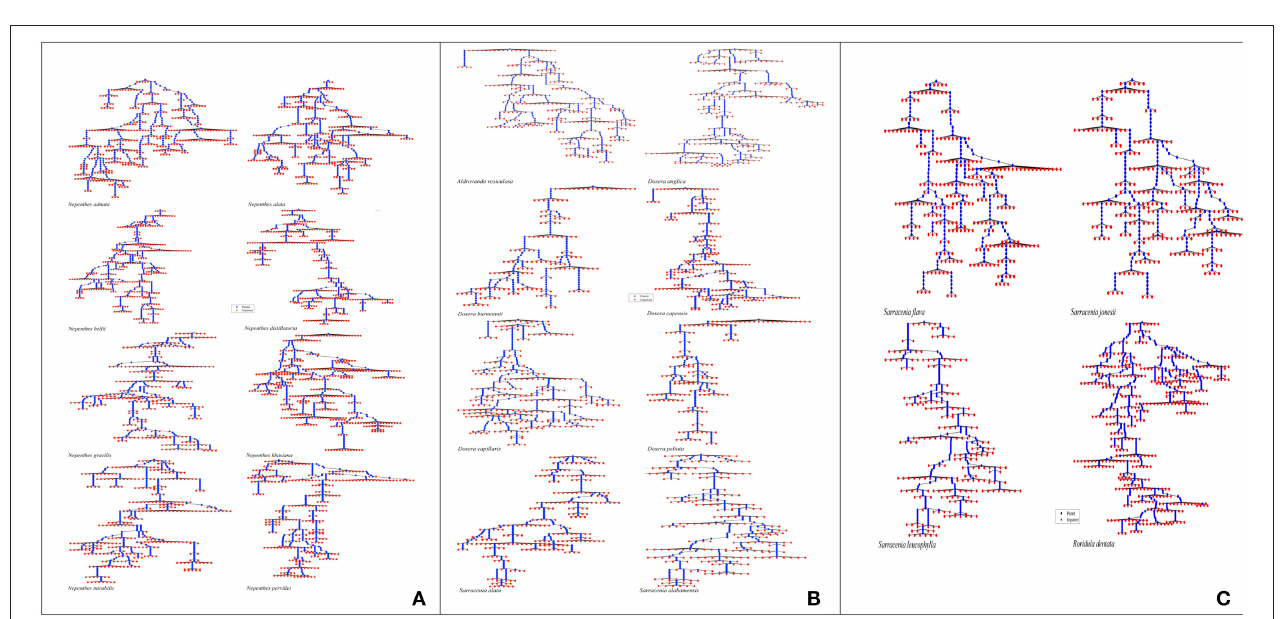
FIGURE 3 | Comparisons of intra- and inter-specific variations among ITS, CoxI, matK, rbcL, rps4, and atpB genes of the carnivorous plant families Nepenthaceae, Droseraceae, Sarraceniaceae, and Roridulaceae. The gray and black bars represent the intra- and inter-specific variations, respectively. The thin, black lines indicate the smallest inter-specific variation. Names next to the dark bars indicate the closest species to that listed on the left.